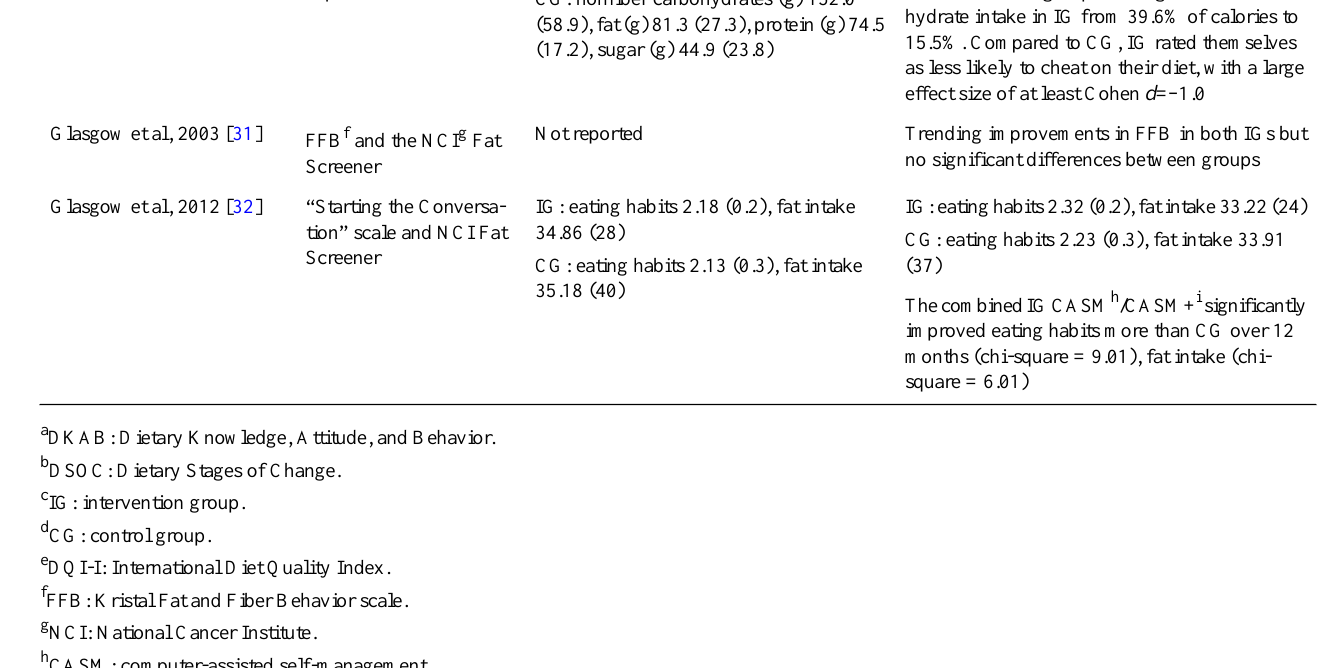
Postintervention dietary changesBaseline dietary assessment resultsDietary